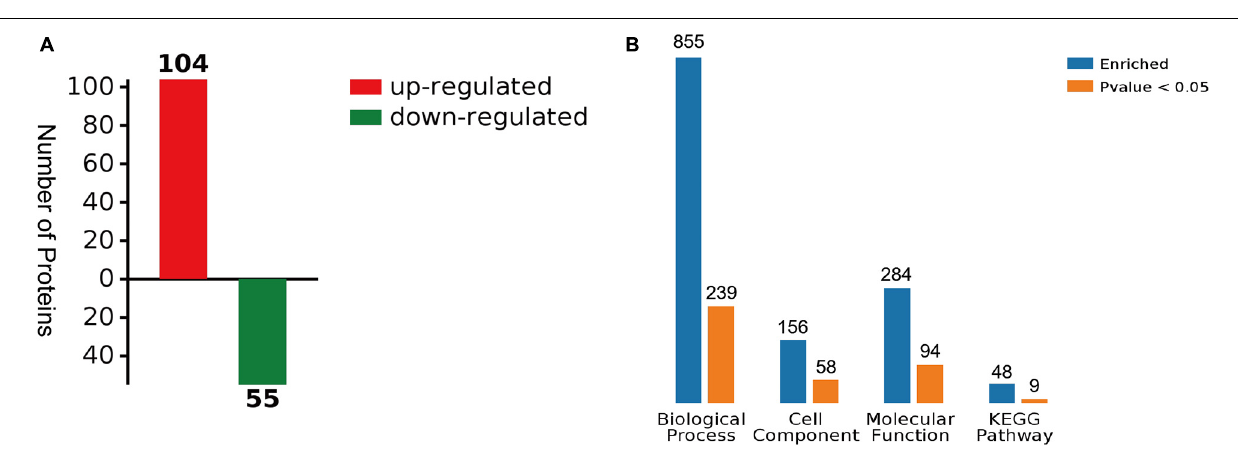
FIGURE 3 | Summary of differentially expressed proteins (DEPs). (A) The number of DEPs between solvent control and OA treatment. (B) Summary of differences and significant numbers of protein GO enrichment (BP, CC, MF) and pathway KEGG enrichment results ( p <